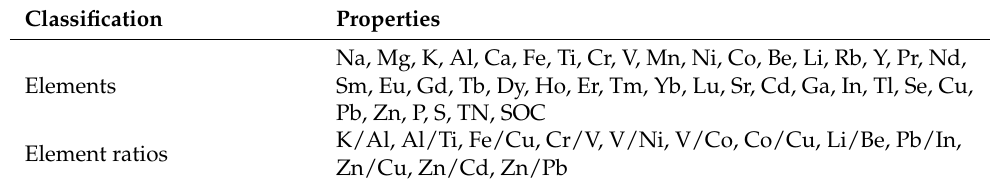
Table 1. Summary of properties